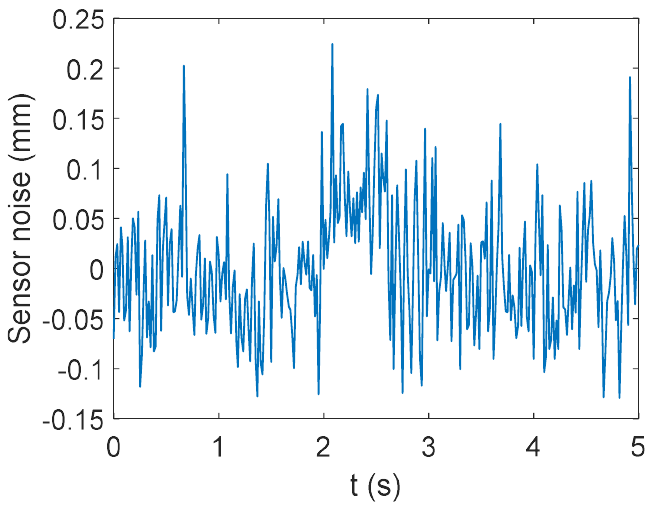
Figure 12. Measurement noise of the motion capture system.